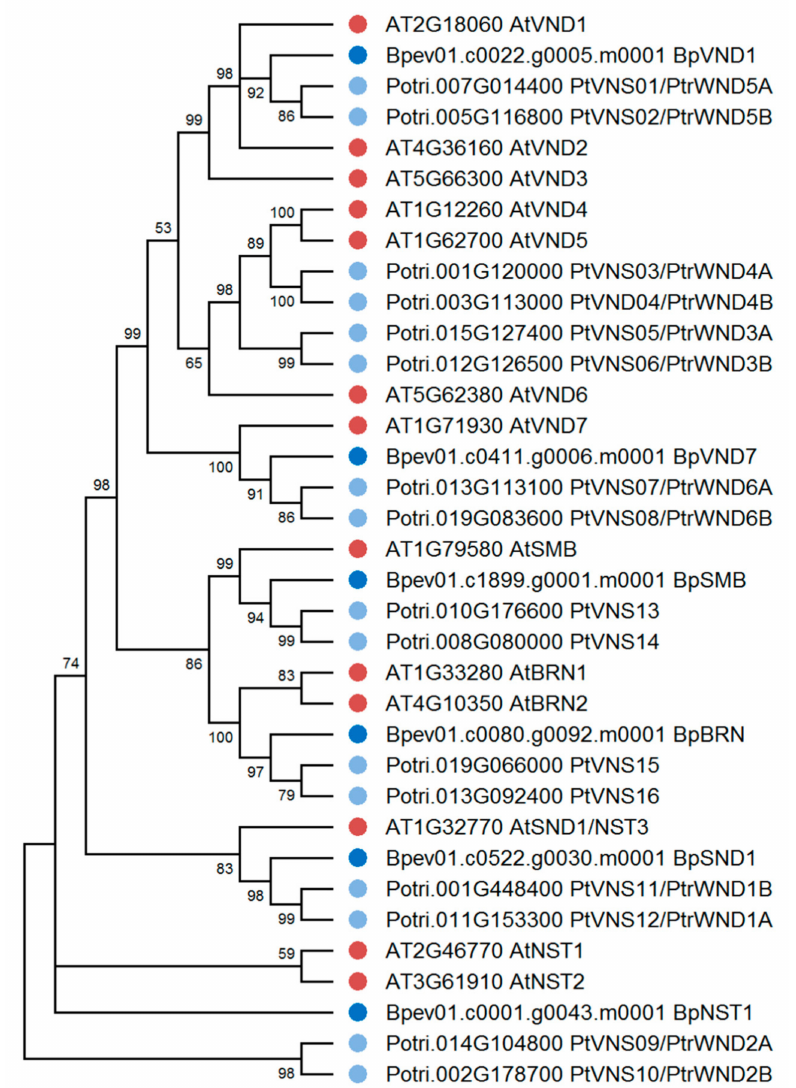
Figure 6. Phylogenetic relationships of Class IIB NACs of B. pendula (dark blue dots), A. thaliana (red dots), and P. trichocarpa (blue dots). Bootstrap values (1000 replicates) are shown next to the branches, and only those values greater than 50 are displayed. The access codes of the A. thaliana and P. trichocarpa proteins in the TAIR and Phytozome databases are indicated next to the corresponding